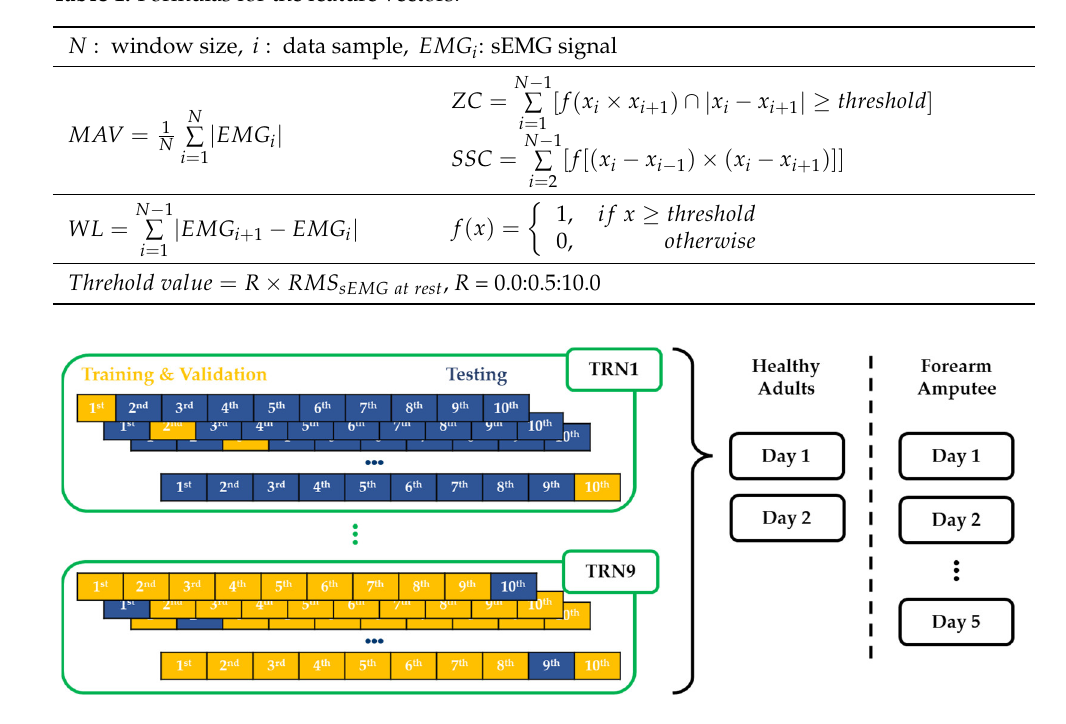
Figure 5. Ten-fold cross-testing of the ANN